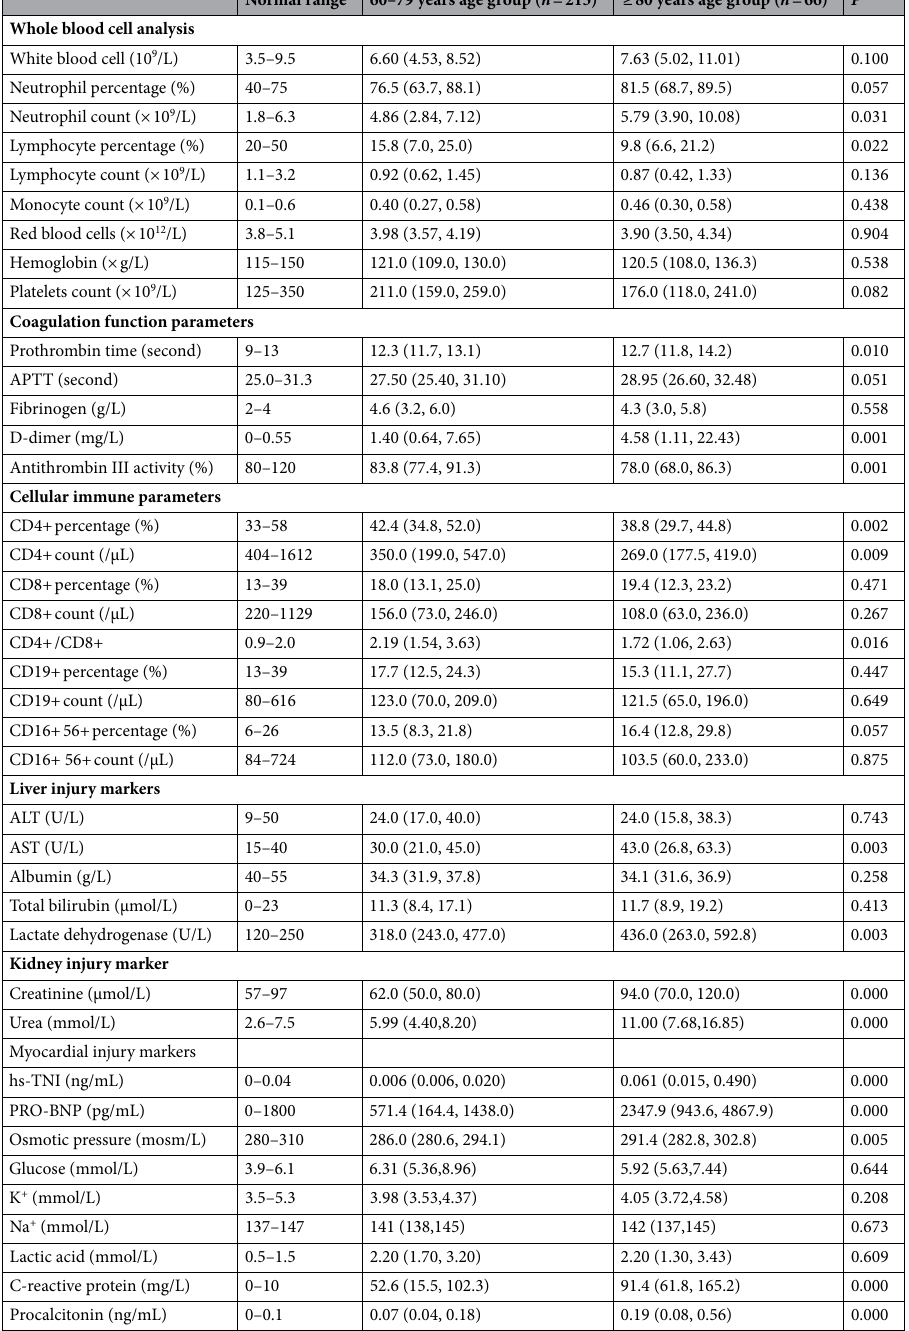
Table 2. Comparison of laboratory findings between the two age groups. Values are medians (interquartile ranges). P indicates the P -values for the comparison of the 60–79 years age group and the ≥ 80 years age group. ALT, alanine aminotransferase; AST, aspartate aminotransferase; APTT, activated partial thromboplastin time; hs-TNI, high-sensitivity troponin I; PRO-BNP, precursor-B-type natriuretic